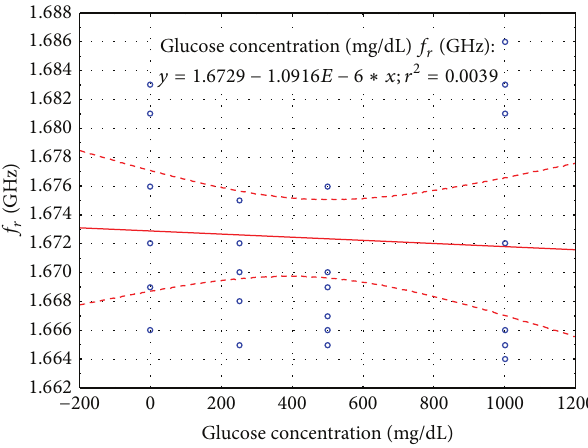
Figure 6: Dependence of sensor resonant frequencies on glucose concentration of physiological saline-glucose solutions; dashed red lines denote 95% confidence interval.